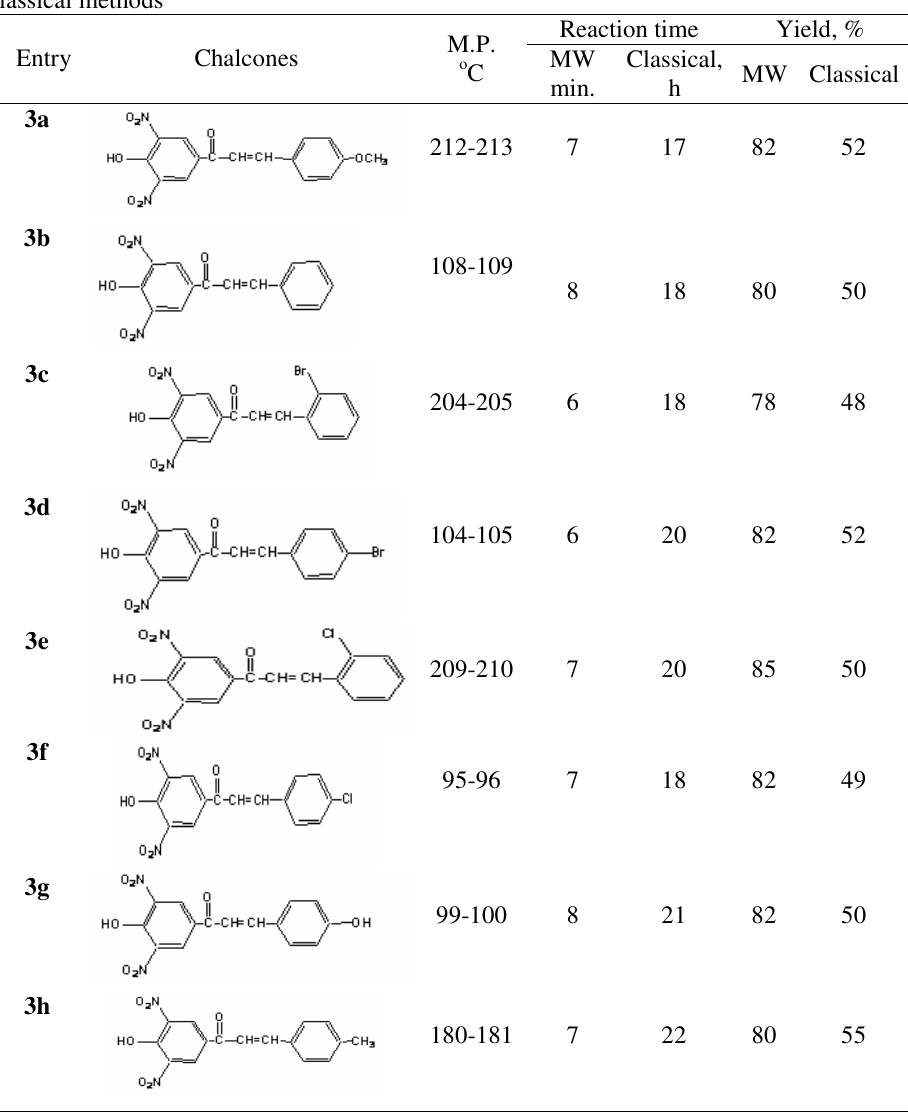
Table 1. Comparison of reaction times and yields of compound ( 3a-h ) under microwave and classical methods